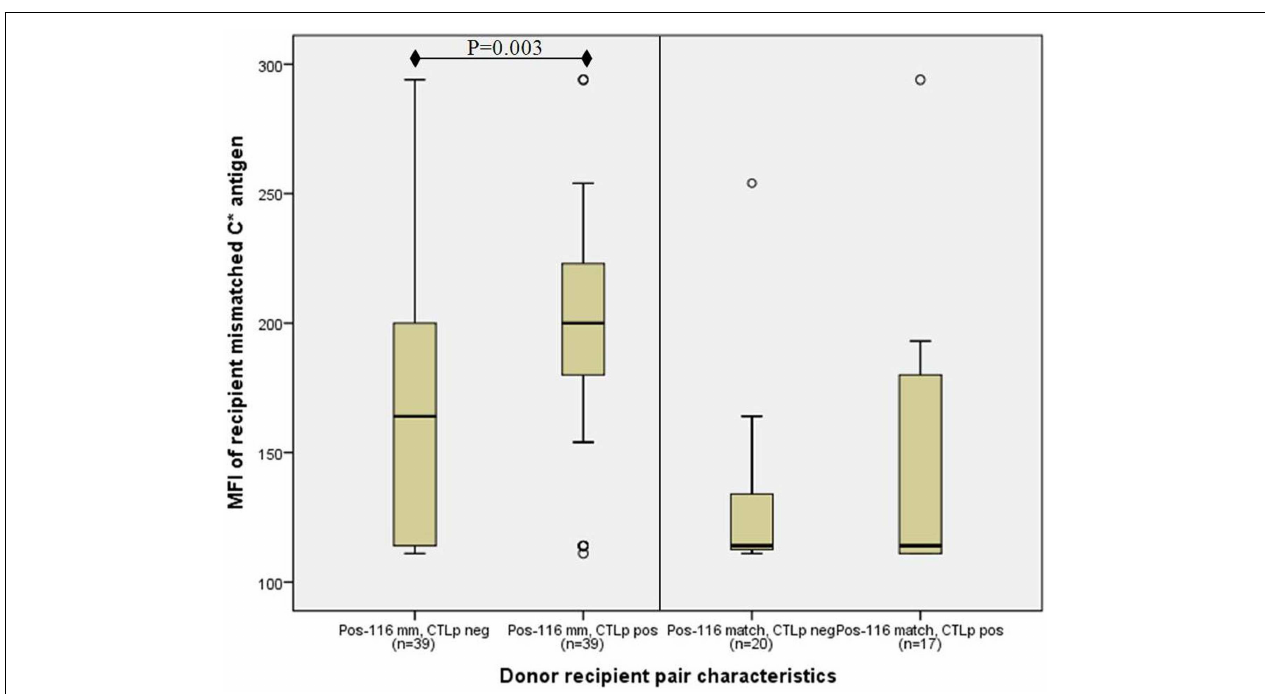
MWU test; left panel). No significant MFI level difference between CTLp positive and negative pairs was identified in cases where position-116 was matched (right panel). Horizontal line represents median MFI, box plot represents MFI values between the 25th and 75th percentiles, and thin whiskers represent